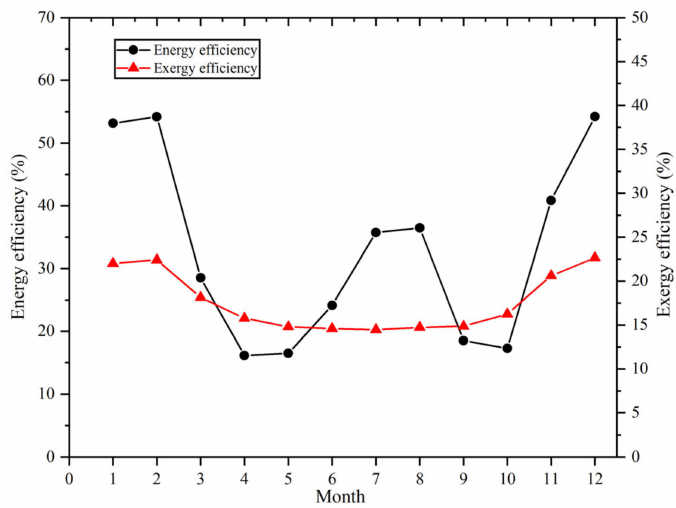
Figure 17. Monthly energy and exergy efficiency of system.